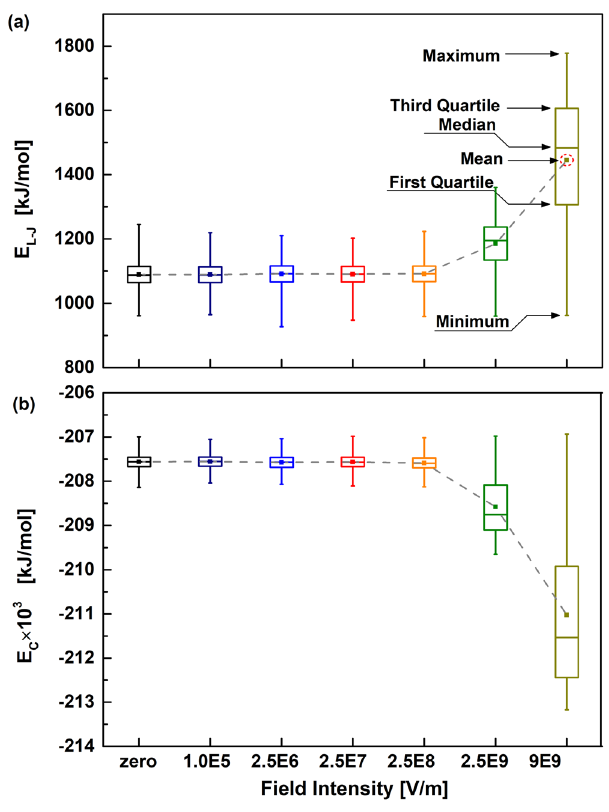
Figure 7. DMSO-ethanol intermolecular interaction energy, split in ( a ) Lennard-Jones and ( b ) Coulombic under microwave fields as a function of field intensity. The values are obtained by statistical analysis of time- dependence intermolecular energy extracted from a 5 ns equilibrium simulation. Dash lines are showed for guiding